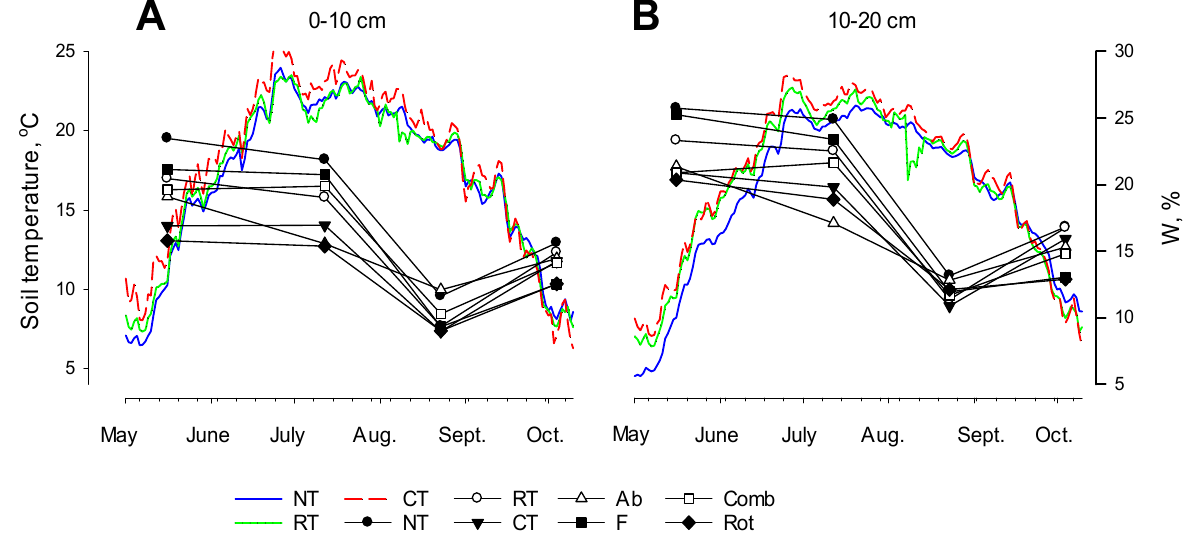
Figure 6. Tillage effect on Mollisol temperature (°C; A ) and moisture (W, %; B ) in the 0–10- ( A ) and 10–20-cm ( B )